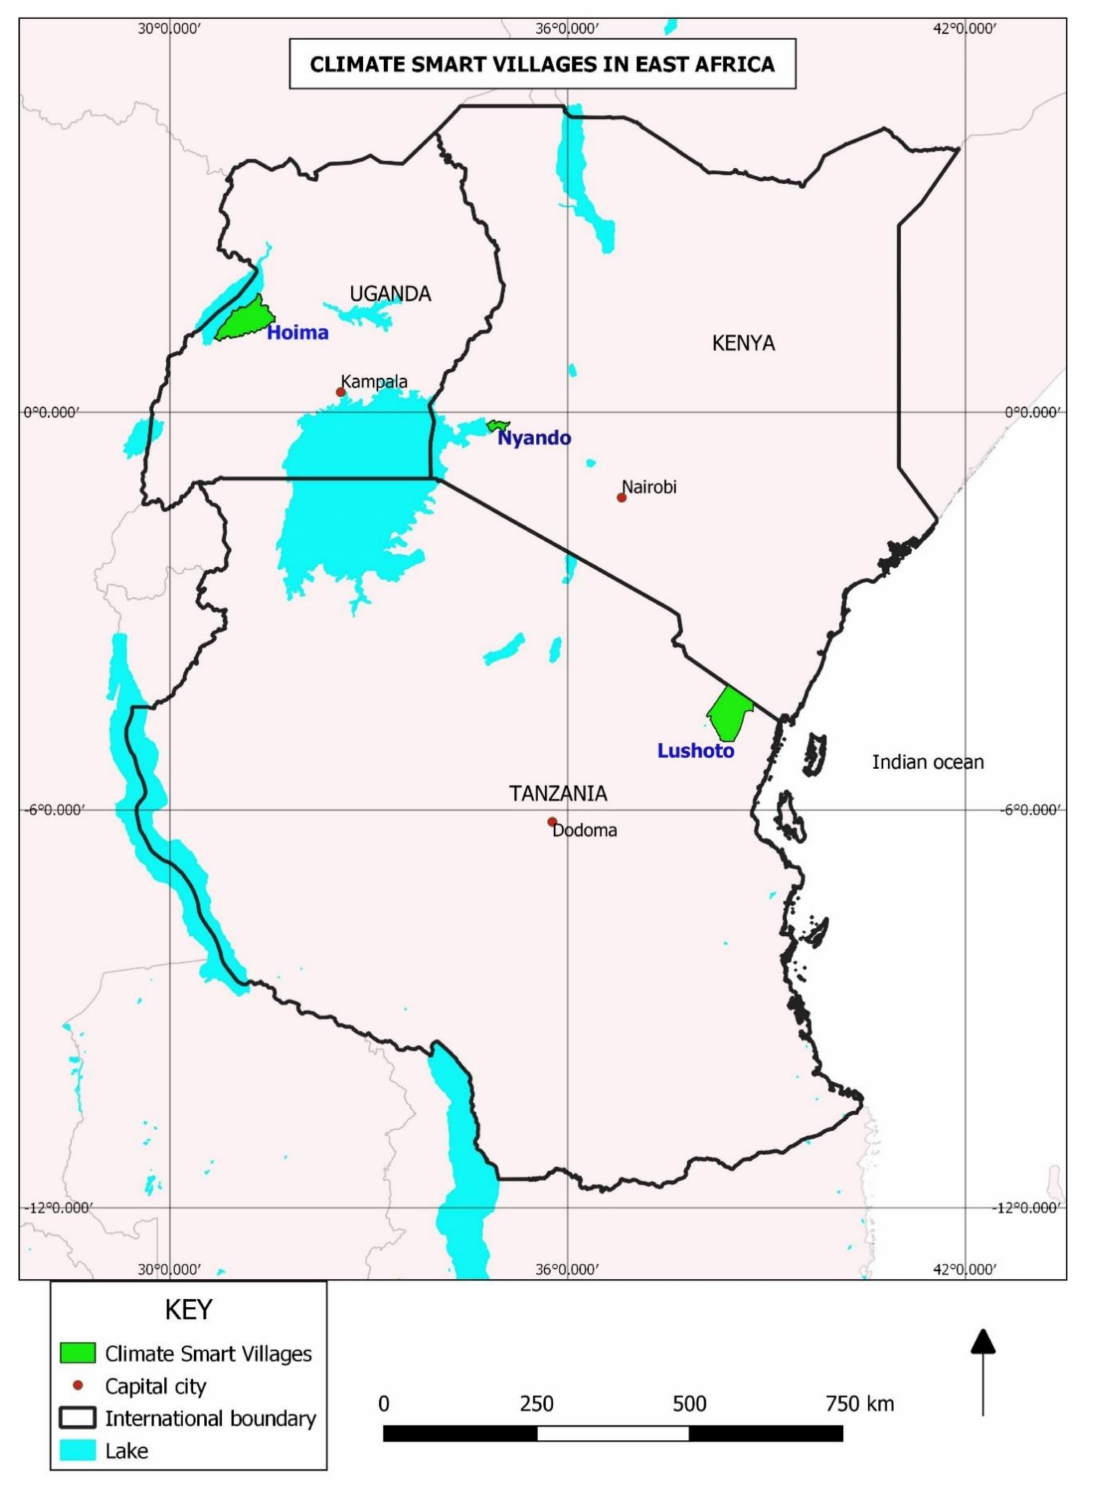
Figure 1. The Hoima, Nyando, and Lushoto Climate-Smart Villages study